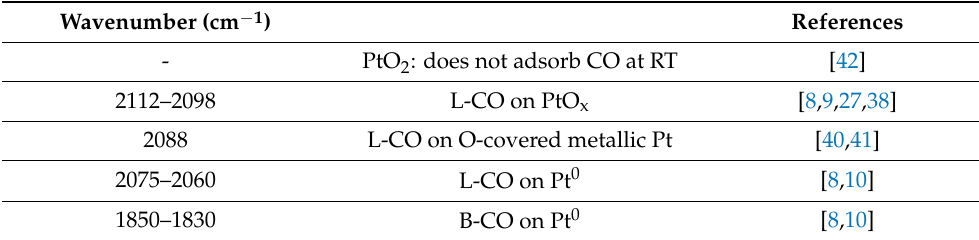
Table 1. Tentative IR band assignments related to CO adsorption. “L” refers to linearly adsorbed CO and “B” to bridged CO between two Pt